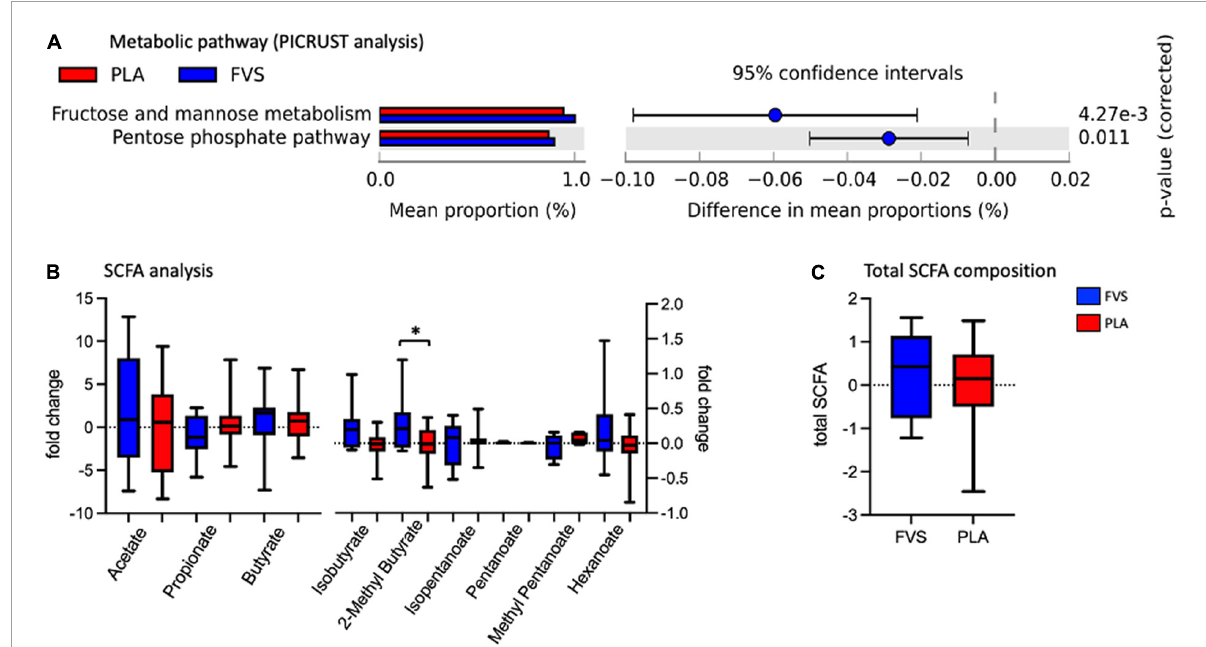
FIGURE6 Predicted functional pathways and metabolite composition in the FVS and PLA groups. (A) Predicted functional pathways are obtained using the PICRUSt tool based on the bacterial abundance measured as mean proportion in the FVS and PLA groups. (B,C) SCFA composition was measured using liquid chromatography–tandem mass spectrometry. Single SCFAs are shown in panel b, and the total of the SCFA in panel c. The median and interquartile (IQR) ranges are showed in box plots. FVS, N = 15, PLA, N = 14. ∗ p < 0.05 when compared with the PLA group using Student’s t- test.